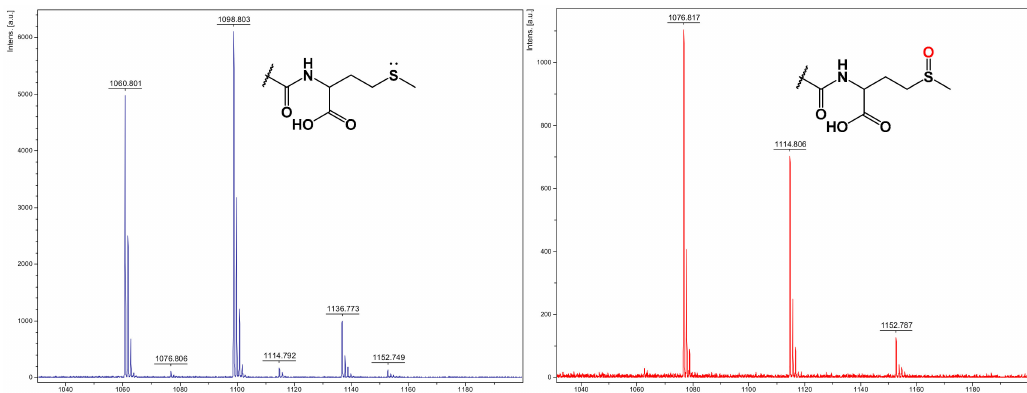
Figure 2. Mass spectra ( m / z ) obtained by MALDI-ToF MS analysis related to A β 25-35 ( left ) and the same peptide with the methionine residue oxidized to methionine sulfoxide ( right ). 1060 and 1076 m / z correspond to Met-A β 25-35 and MetSO-A β 25-35 , respectively. The peaks at 1098, 1136, 1114, and 1152 m / z are related to their + K [M + 39] and + 2K [M + 76] m / z adducts.